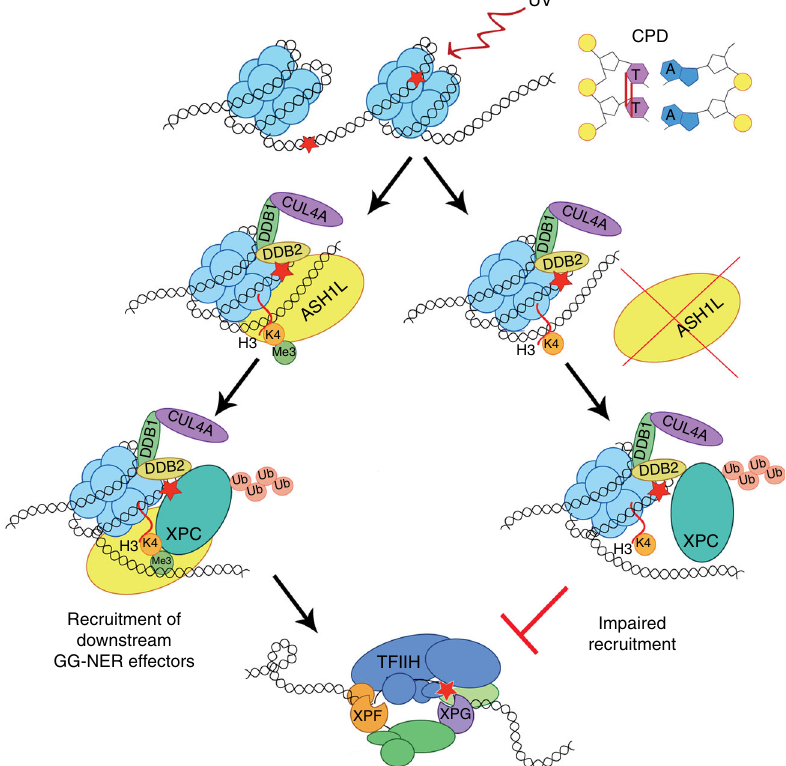
Fig. 9 Model of CPD recognition in nucleosome cores. UV irradiation induces CPDs that are distributed evenly in chromatin and, hence, are formed also within nucleosome cores where the DNA is wrapped around histone octamers. Recognition of CPDs in nucleosome cores by DDB2 leads to recruitment of the histone methyltransferase ASH1L and, as a consequence, to methylation of the amino-terminal tail of histone H3 at position lysine 4. The presence of methylated H3 facilitates the stable docking of the XPC subunit to damaged sites in the nucleosome core, such that XPC protein is endowed with the ability to induce downstream GG-NER reactions, including DNA unwinding by TFIIH and dual DNA incision by the XPG and XPF-ERCC1 endonucleases. In the absence of ASH1L and H3K4 methylation, the loose interaction between DDB2 and XPC is not suf fi cient to initiate the GG-NER reaction at nucleosomal